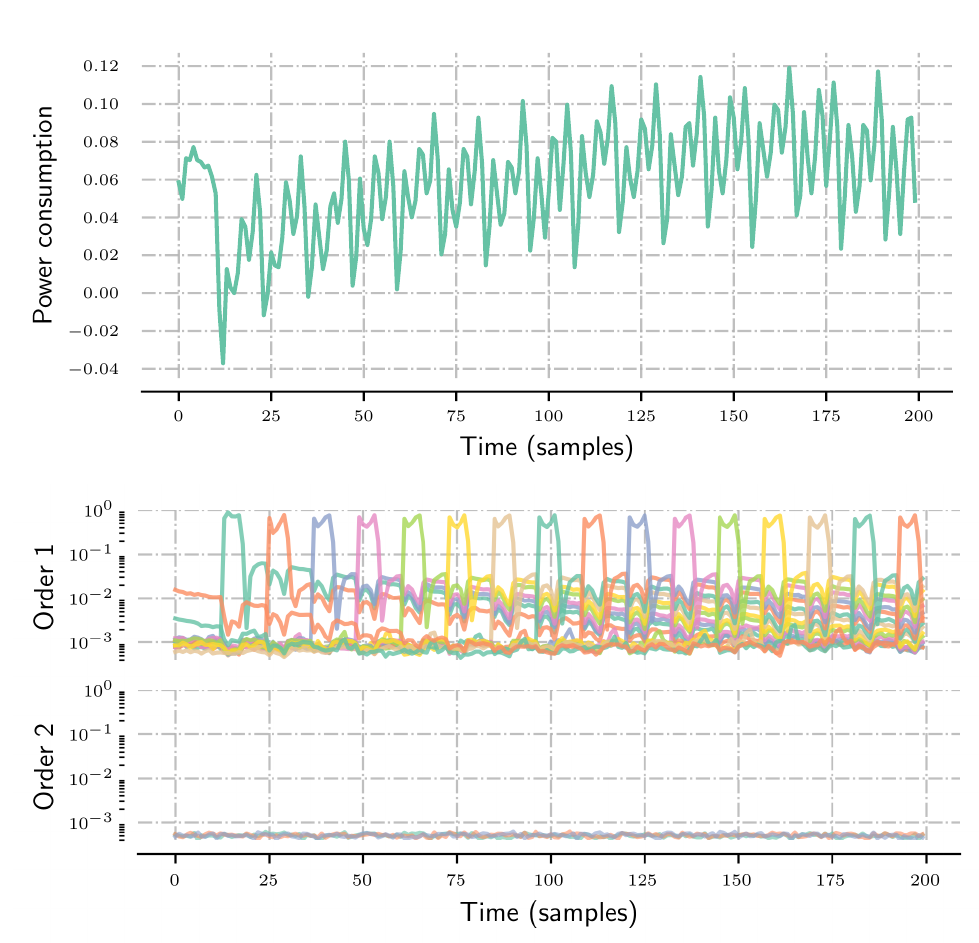
Figure 4: Top: an example of trace. Bottom: the SNRs of order 1 and 2 (in logarithm